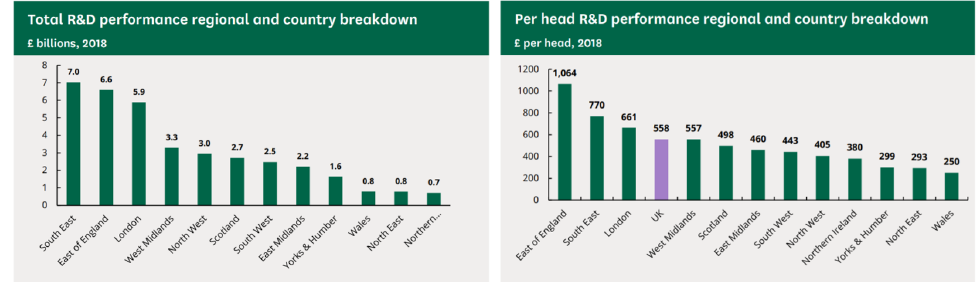
Figure 5. Research and development expenditure by region in England.